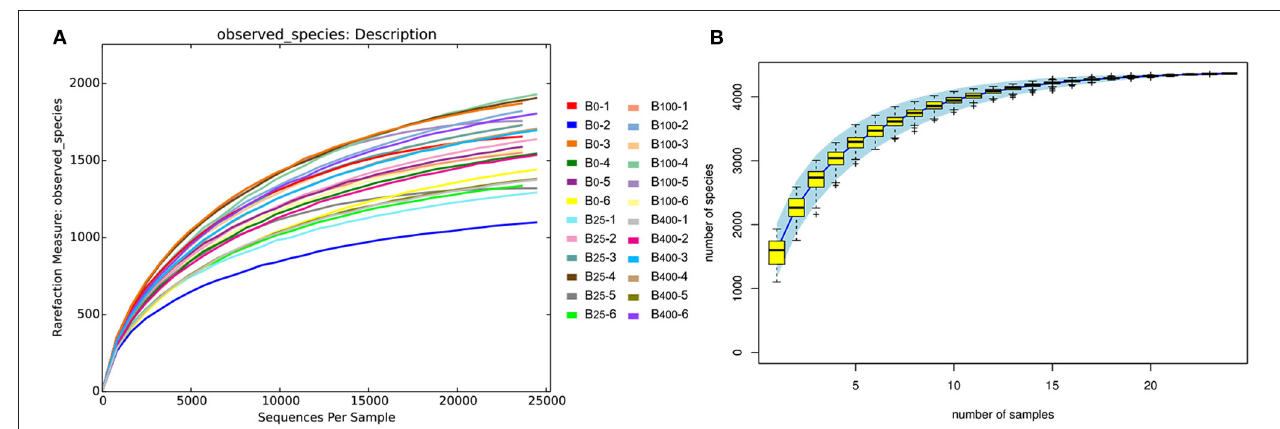
FIGURE 2 | (A) Rarefaction curves and (B) species accumulation curve diagram analysis of proportion of the cecal microbes in different treatments.